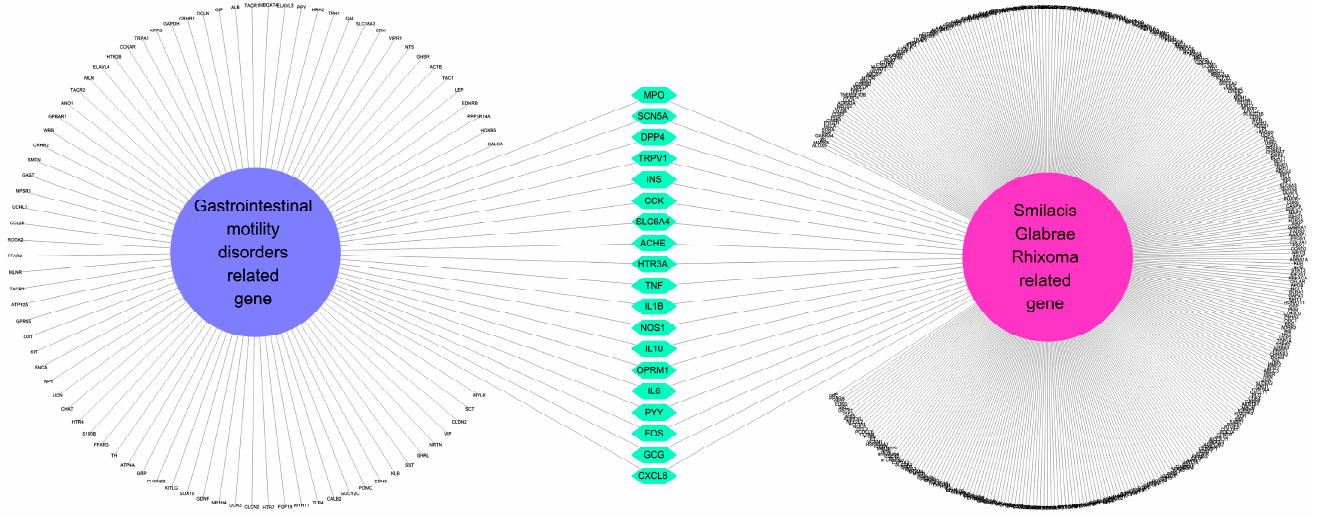
Figure 4. Network of GMD-related genes and SGR target genes. The 19 genes included in both “gene related to gastrointestinal motility disorder” and “ Smilacis Glabrae Rhixoma target genes” are classified in the center. GMD: gastrointestinal motility disorder. SGR: Smilacis Glabrae Rhixoma.